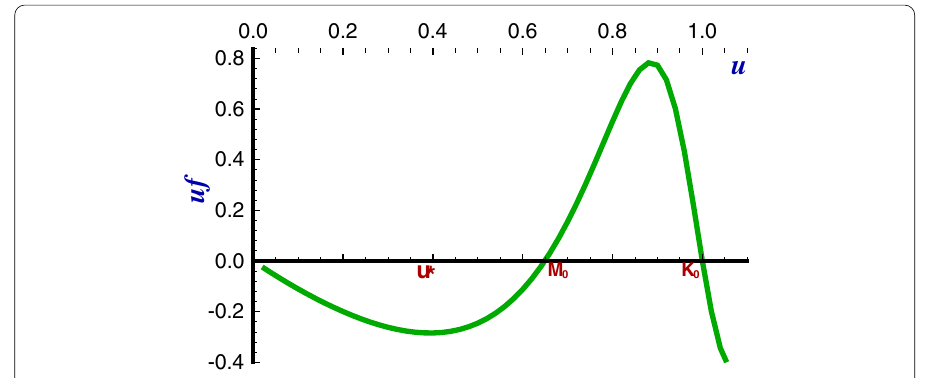
1.1 cos (π x ) , K ( x ) = +